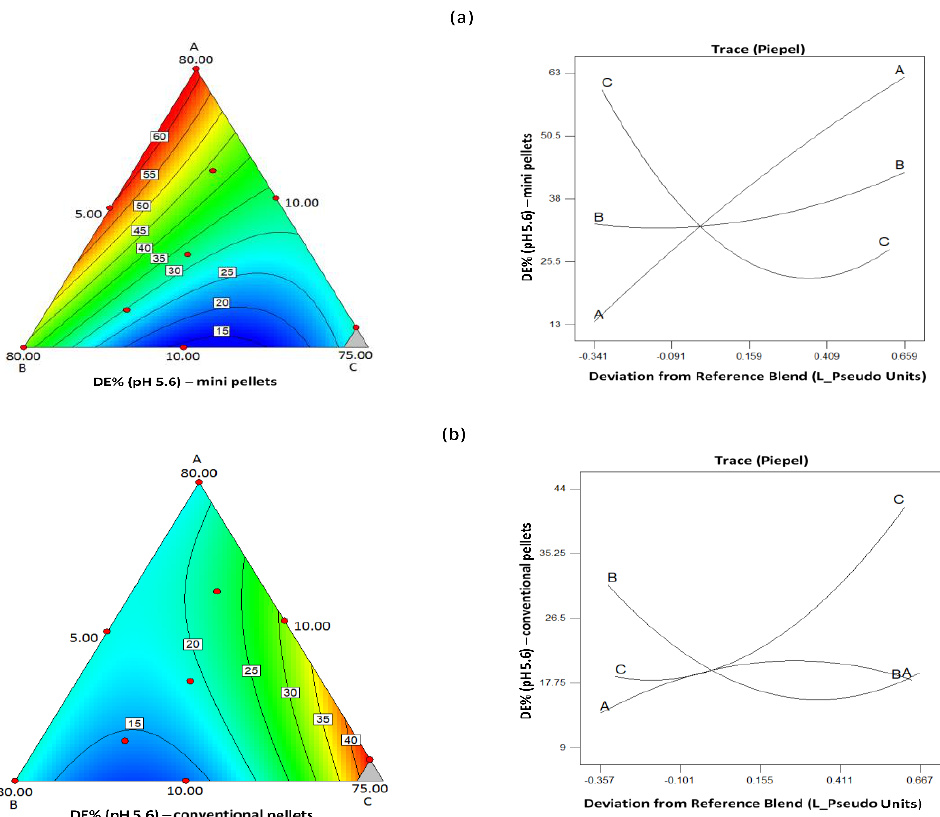
Figure 12. Contour and trace plots of dissolution efficiency for ( a ) mini and ( b ) conventional pellets at pH 5.6.